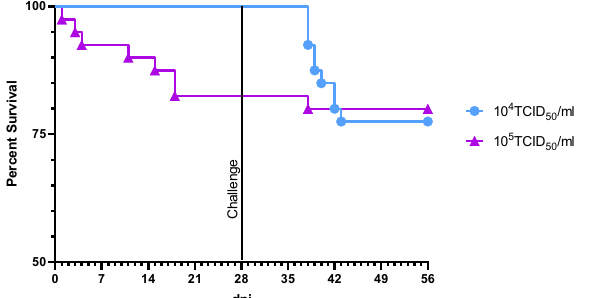
Fig. 2 Improvement of vaccination procedure with KHV-T P78. Dose dependence of virulence and protective ef fi cacy of KHV-T P78. Carp were infected by immersion with 10 4 TCID 50 /mL of KHV-T P78, and challenged with 10 5 TCID 50 /ml of wild type KHV after 28 days. Survival rates in this experiment (blue line), and in the previous study with 10 5 TCID 50 /ml of KHV-T P78 (purple line) are compared.